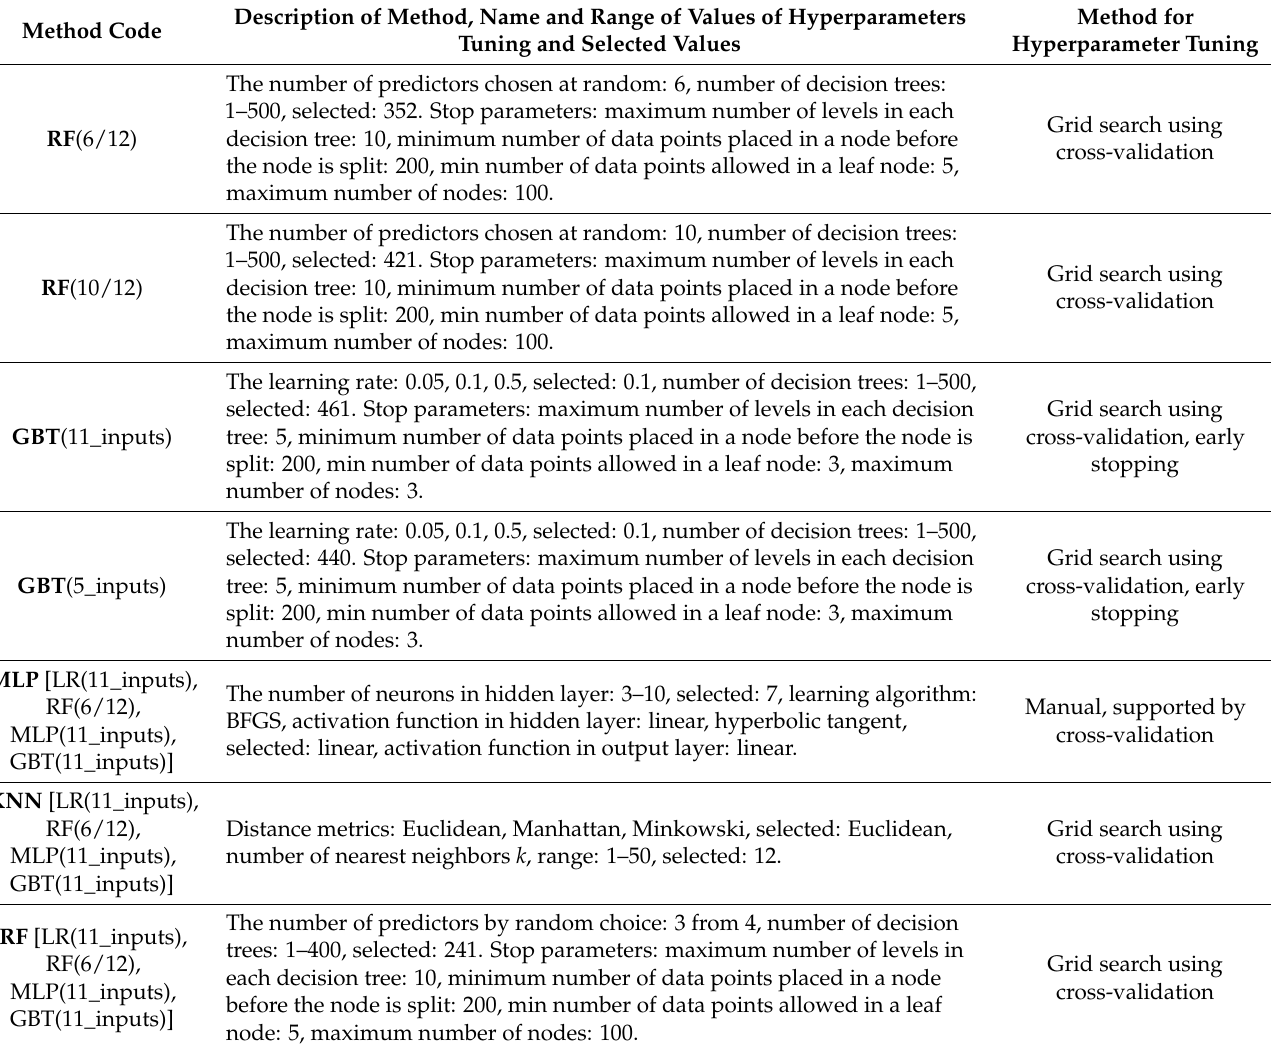
Table A2. Results of hyperparameter tuning for the proposed ensemble methods for time series No. 1. Method Code